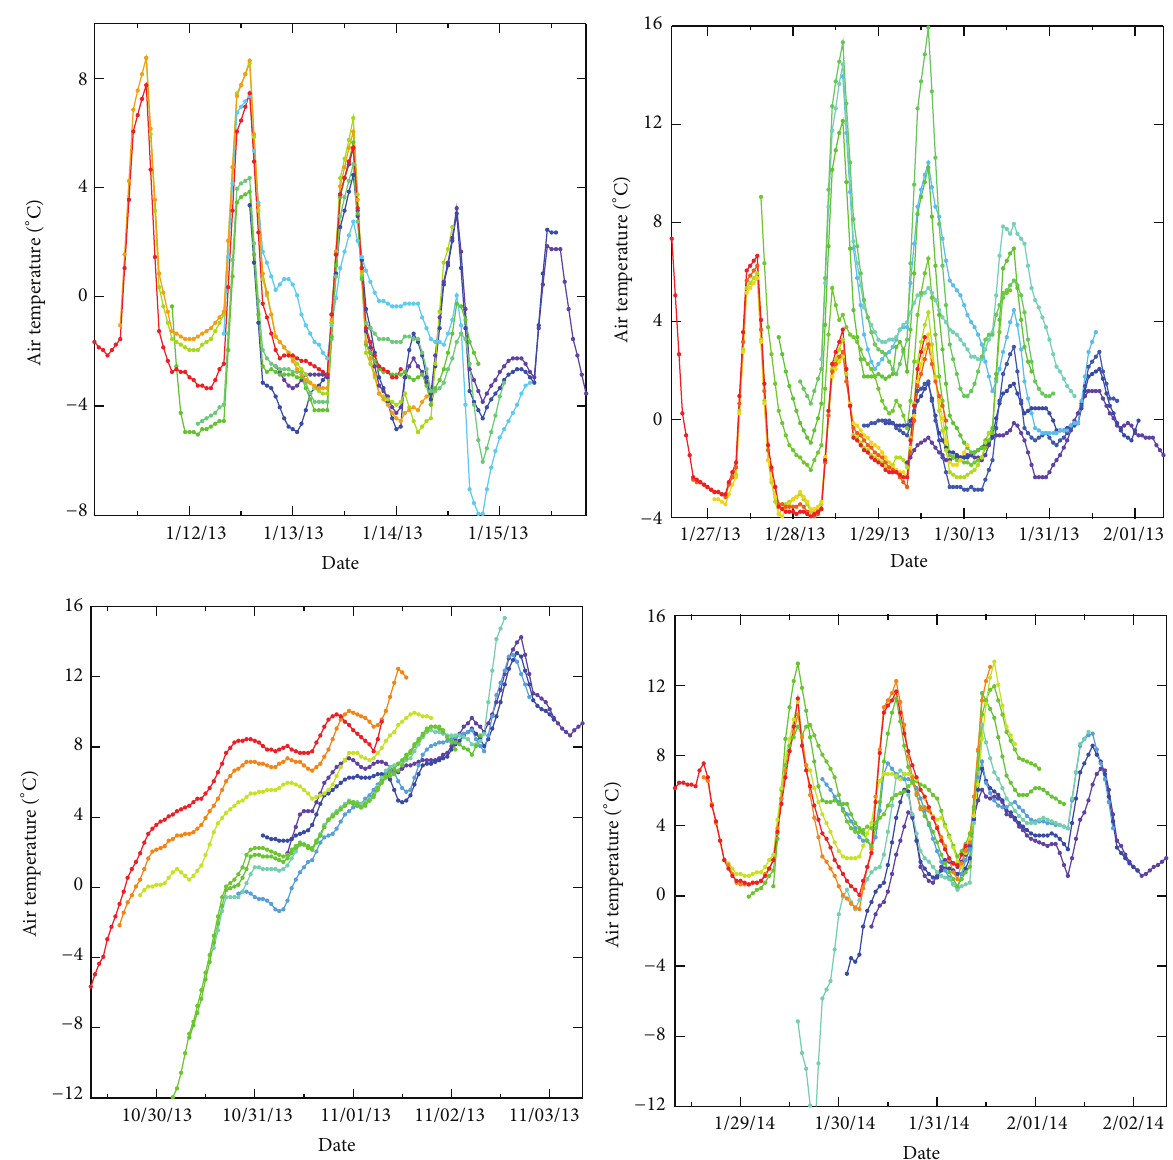
Figure 3: Changes in temperature along the air-mass back trajectories for the four fog events occurring in Ji’nan during the period from March 2012 to February 2014.